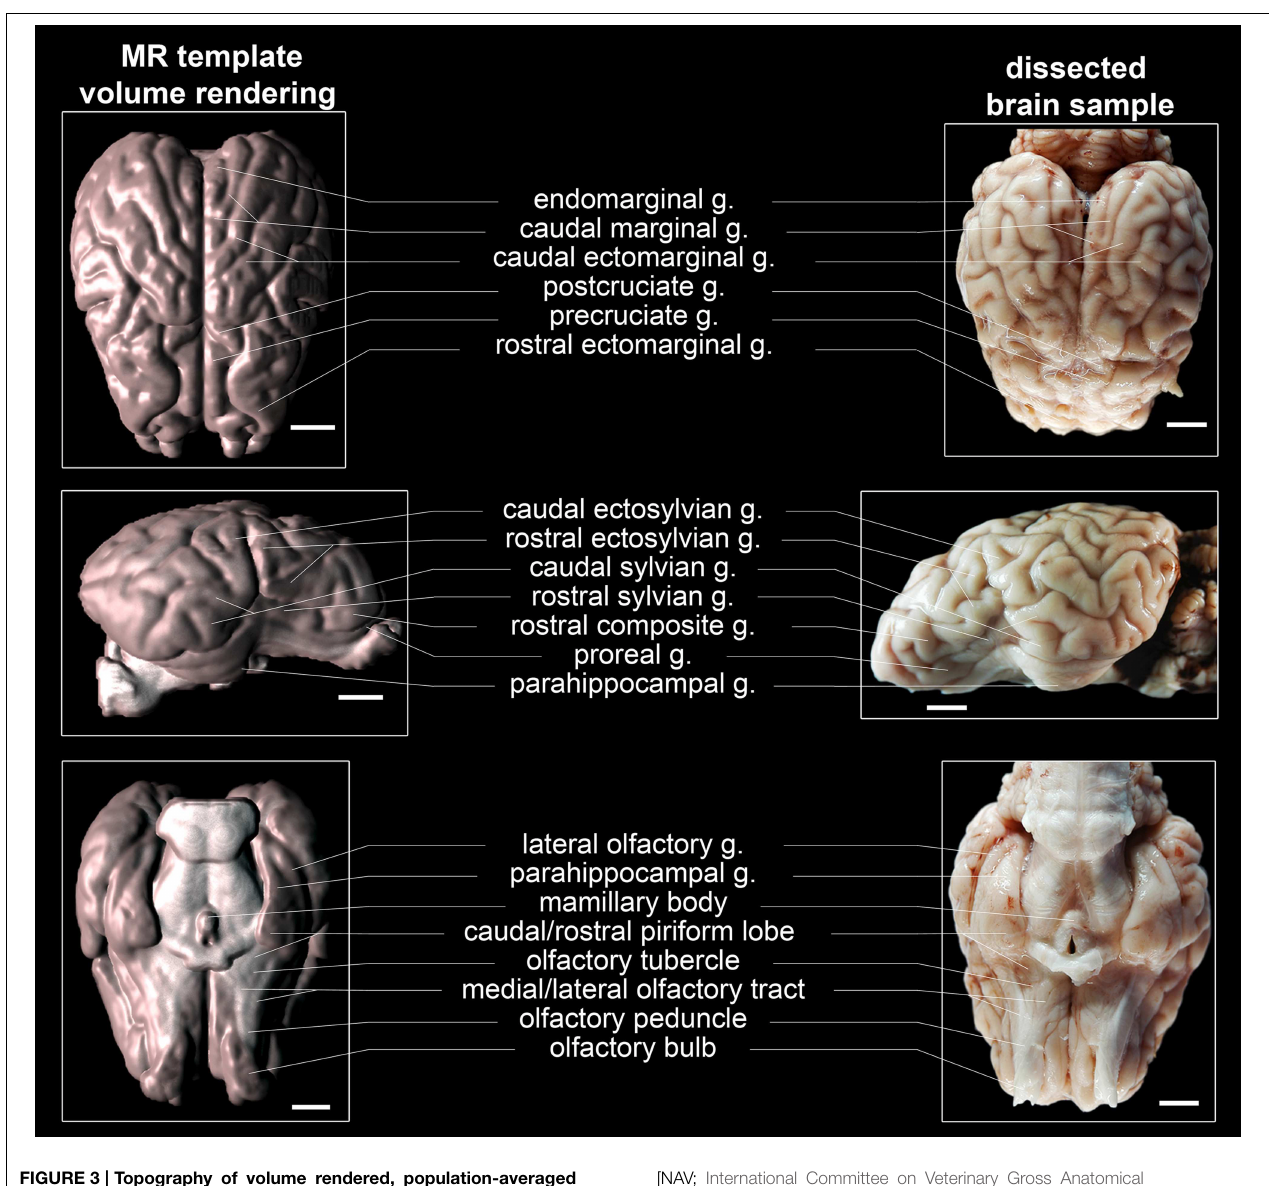
[NAV; International Committee on Veterinary Gross Anatomical Nomenclature (ICVGAN), 2012] except the endomarginal gyrus, which is not differentiated from the marginal gyrus according to the NAV. Scale bars: